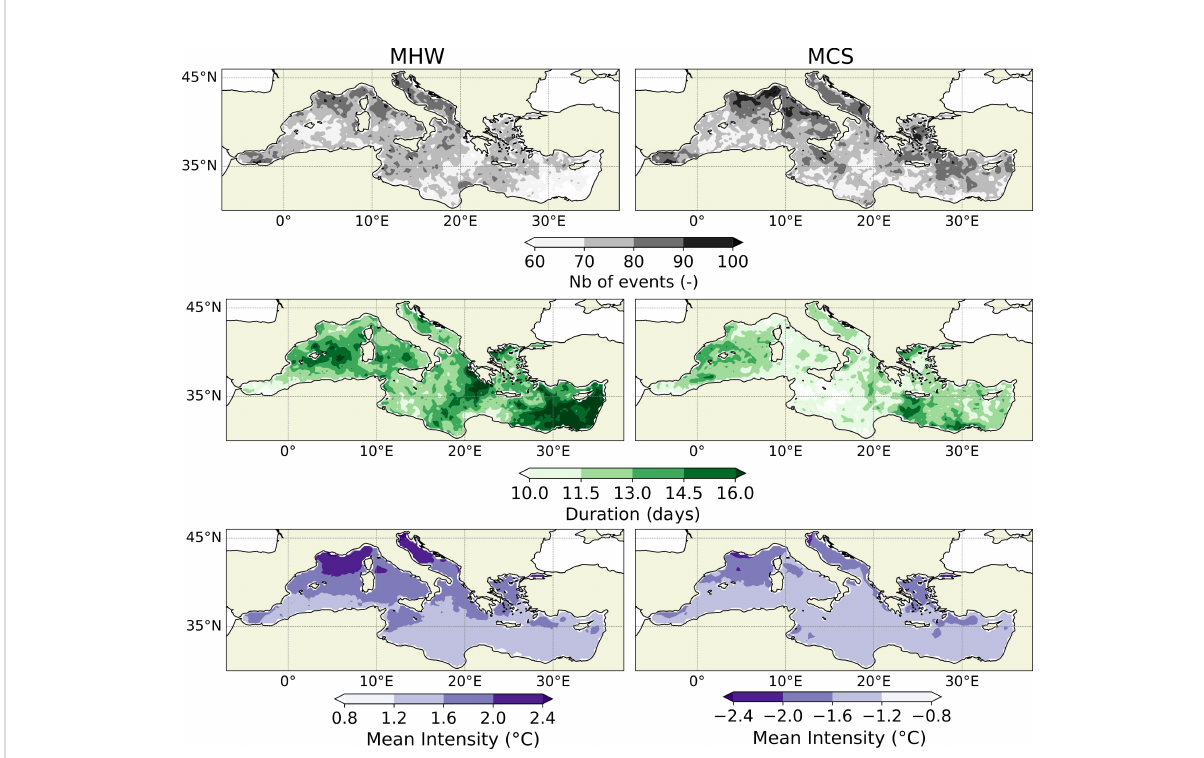
FIGURE 2 Number of events (top), average duration (middle; in days) and average intensity (bottom; °C) for all detected MHWs (left) and MCSs (right) within the period 1982-2021 in the